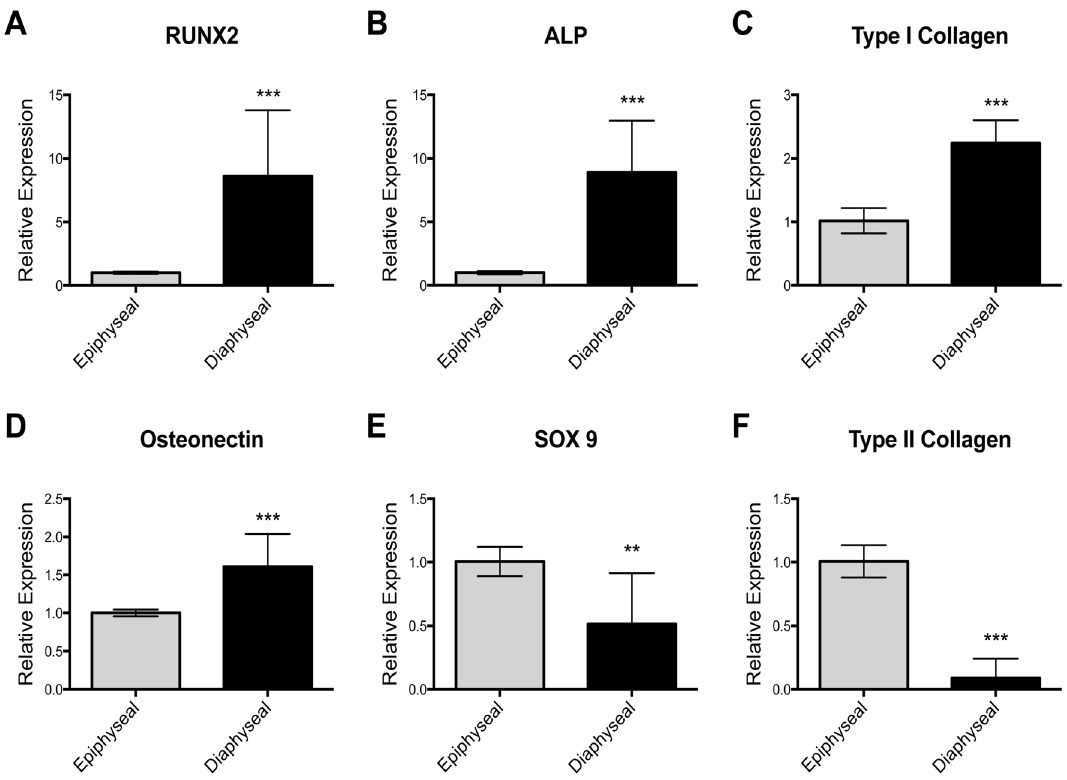
Figure 2. Relative expression (RT-qPCR) of osteogenic and chondrogenic marker genes in epiphyseal and diaphyseal cell population following monolayer culture. Cells extracted from the diaphyseal region expressed higher levels of osteogenic marker genes; RUNX2 , ALP , Type I collagen and Osteonectin (A–D) while epiphyseal cells expressed higher level of genes associated with chondrogenesis; SOX9 and Type II collagen (E–F). Relative expression was normalized to b -Actin with epiphyseal cell populations set to have an expression of one. Data are represented as an average of three independent patient samples and error bars represent standard deviation. **P , 0.01; ***P , 0.001.